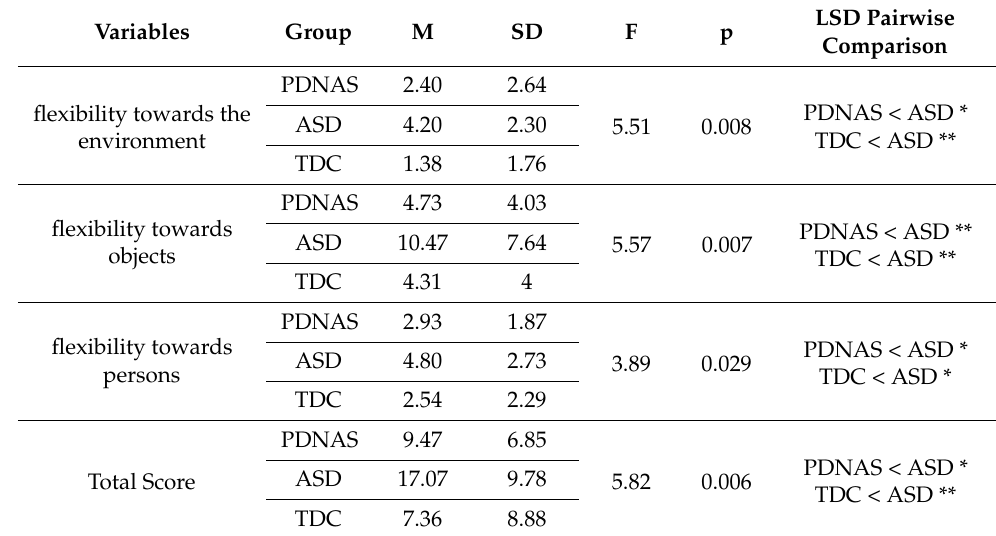
Table 4. Comparison of the severity of behavioral flexibility problems in three